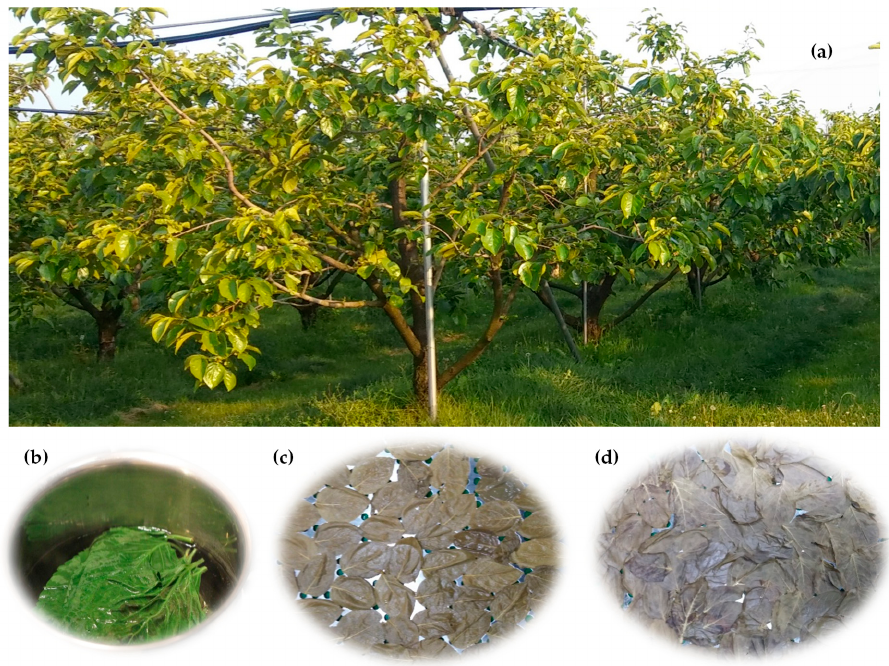
Figure 1. Persimmon ( D. kaki ) plant ( a ), and the preparation of tea ( b ), blanched leaves ( c ), and dried leaves ( d ). These leaves are deciduous and bluish-green in color, which turn into orange, yellow, or red in the autumn. They are simple, alternate, and ovate elliptic in shape and have a mild flavor with a slightly bitter, astringent, and sweet taste. The fruit of this plant are typically harvested during the fall season (September to October) [10]. Almost every part of the persimmon plant, including fruits, peels, seeds, leaves, and bark, has been used in traditional medicine, especially young leaves, which are mainly used as functional tea due to their abundance of antioxidants. Generally, mature leaves with less antioxidative com- pounds are not considered for tea, and this could be due to the movement of bioactive compounds (e.g., antioxidants) from leaves to fruits during fruiting [13]. 3. Traditional Uses and Industrial Potential Young PL have long been used as a traditional tea (gamiph-cha, kakinoha cha, or guilin ye qing tea) in Asian cultures. This is a caffeine-free tea, which tastes slightly bitter with a very pleasant flavor, consumed mainly to promote a healthy diet and as an anti- aging ingredient due to the presence of high levels of flavonoids and vitamin C [14,15]. Tea made from dried leaves is very common, but it is also prepared from fresh green leaves. The major compounds of PL are flavonoids, tannins, vitamins, and terpenoids. PL have long been considered a traditional medicine to treat ischemic angina, stroke, internal hemorrhage, hypertension, atherosclerosis, and infectious diseases, as well as paralysis, frostbite, burns, and constipation, which have been mentioned in ancient Chinese medical books [10,16]. In particular, NXQ is a protected drug of Traditional Chinese Medicine and is used in managing cardio- and cerebrovascular diseases [5]. Traditionally, PL have also been used to promote maternal health [10]. Furthermore, NXQ has been shown to have beneficial effects for the treatment of atherosclerosis, stroke, transitory ischemia